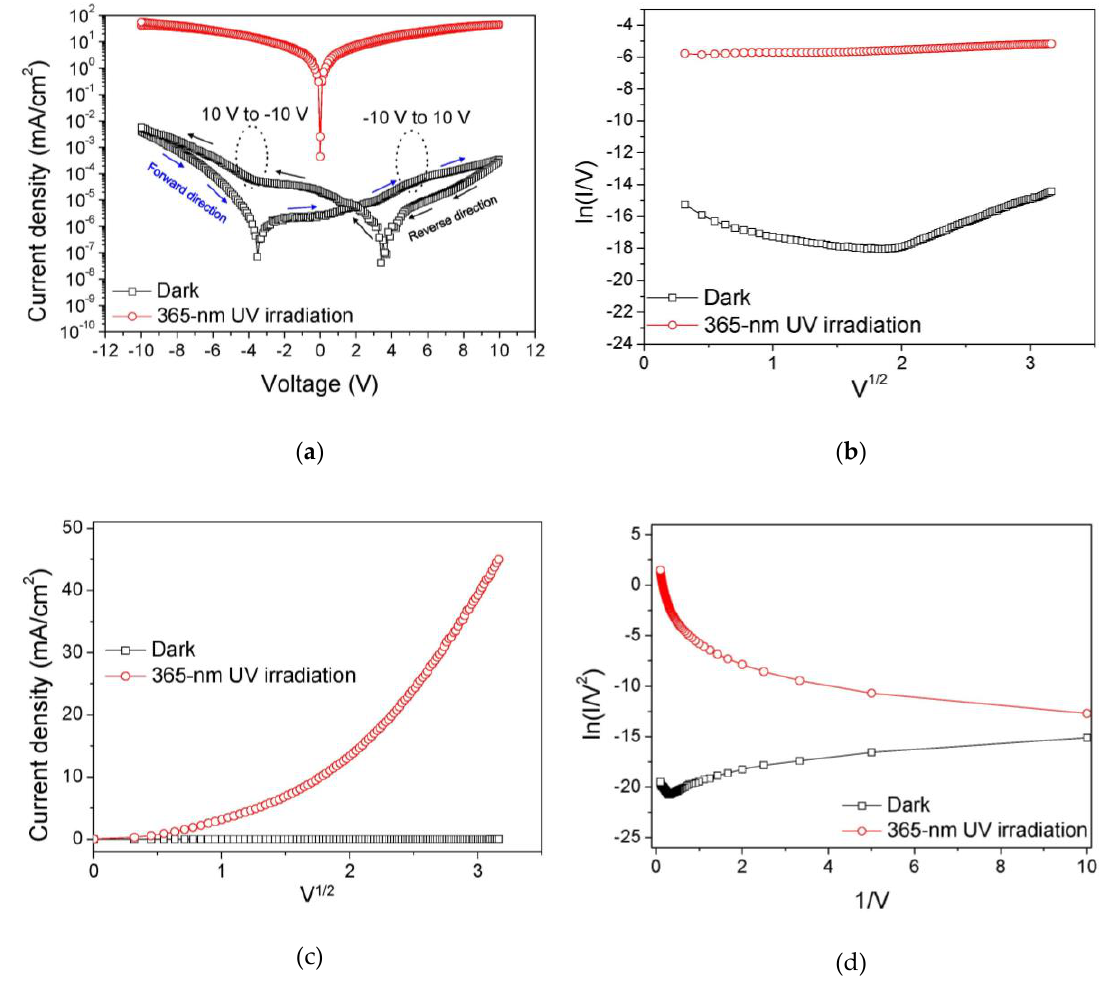
Figure 2. ( a ) Dark and photoresponsive I–V characteristics of the fabricated GaN metal-semiconductor-metal (MSM) photodetector under varying bias from − 10 V to 10 V (forward direction) and from 10 V to − 10 V (reverse direction). ( b ) Poole–Frenkel emission plot, ( c ) Schottky emission plot, and ( d ) Fowler–Nordheim tunneling plot of the I–V characteristics under dark and 365-nm UV irradiation conditions.